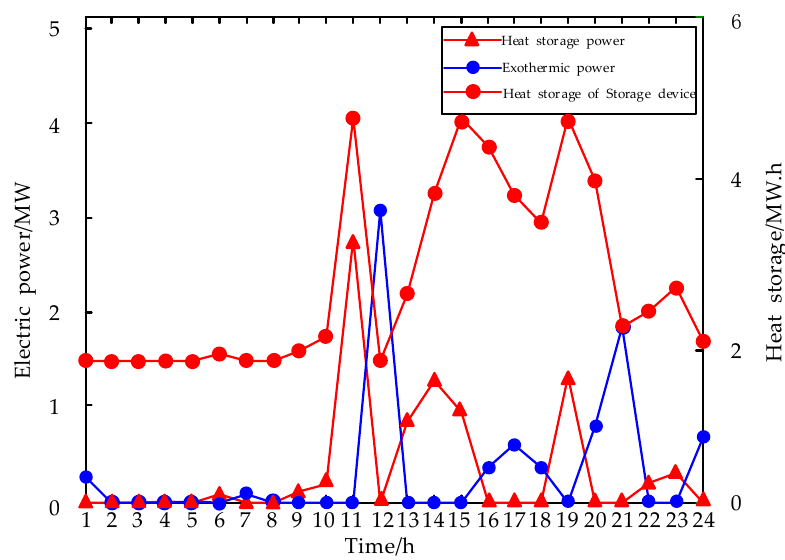
Figure 8. Thermal storage power and exothermic power of heat storage system.